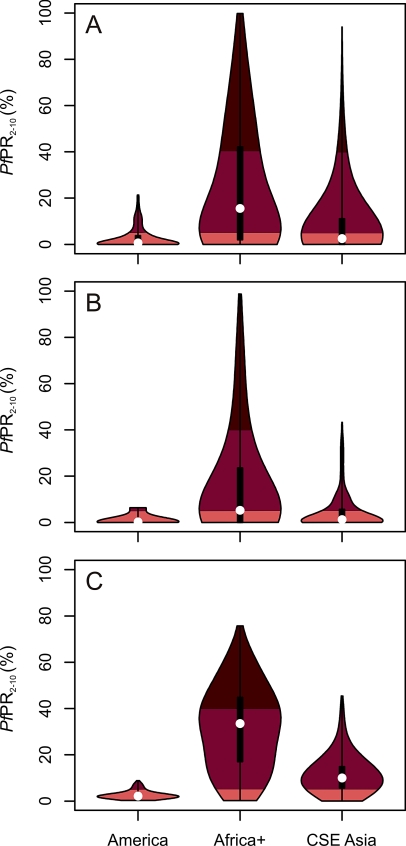
Violin Plots Showing for Each Region Frequency Distributions of PfPR2−10 data(A) For all years, (B) for 2007, and (C) for the predicted 2007 surface. The width of each polygon illustrates the relative frequency of different PfPR2−10 values within each region. The background is coloured to match the endemicity classes shown in Figure 4. The black central bar indicates the inter-quartile range and white circles indicate the median values (see text).